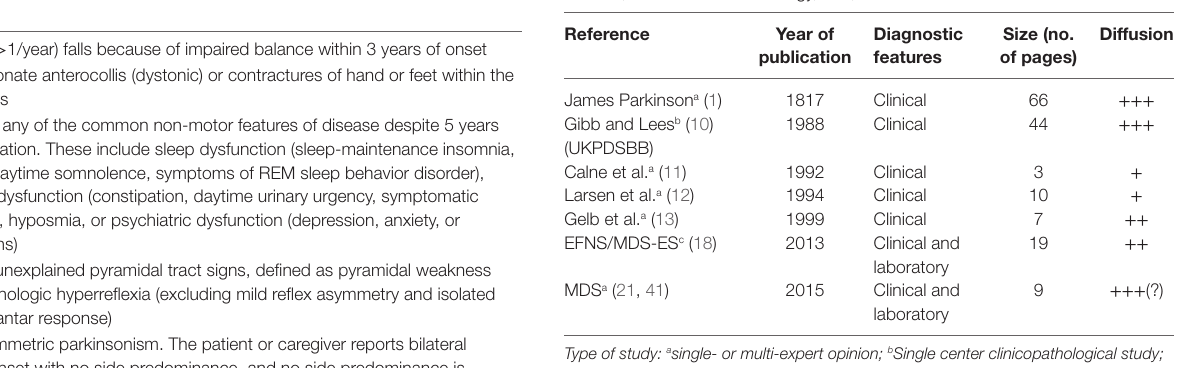
TABle 2 | Synopsis of the main diagnostic criteria proposed for Parkinson’s disease, in terms of methodology, size, and relative